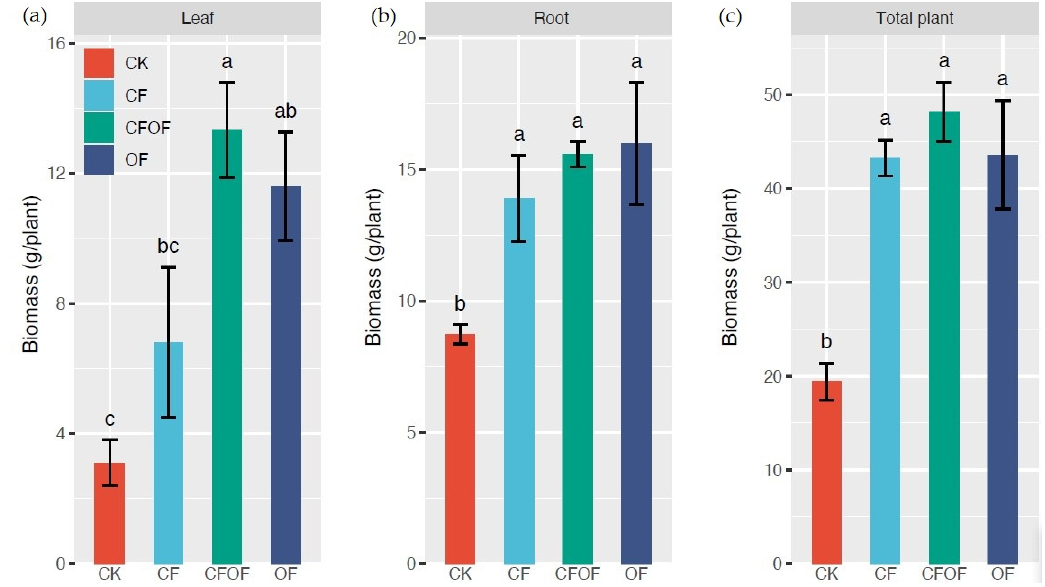
Figure 2. Biomass of leaf ( a ), root ( b ) and total tea plants ( c ) as affected by different fertilization treatments. CK, control treatment; CF, 100% chemical fertilizer; CFOF, 50% chemical fertilizer + 50% bio-organic fertilizer; OF, 100% bio-organic fertilizer. Different letters on each bar represent signifi- cant differences among treatments at a significance level of p < 0.05.